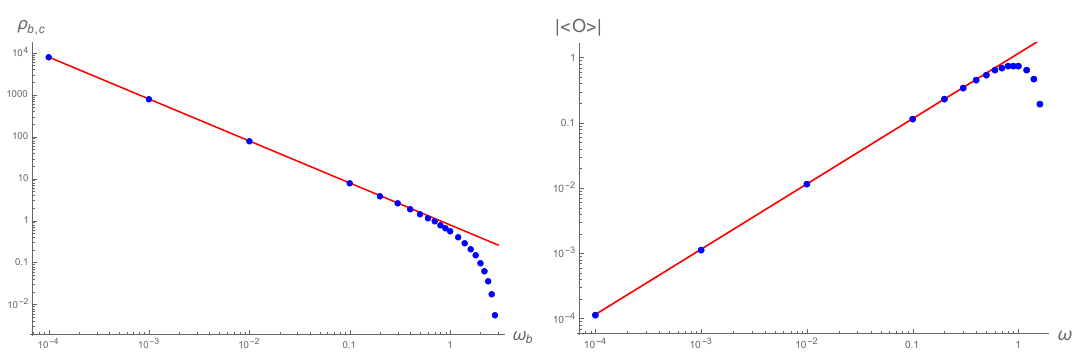
Figure 38 . Left: critical values (cid:26) b;c as a function of ! b (blue dots); the red line corresponds to the analytical prediction (cid:26) b;c = (cid:11) (cid:3) =! b . Right: jhO c ij of the critical SPS’s (blue dots), together with b